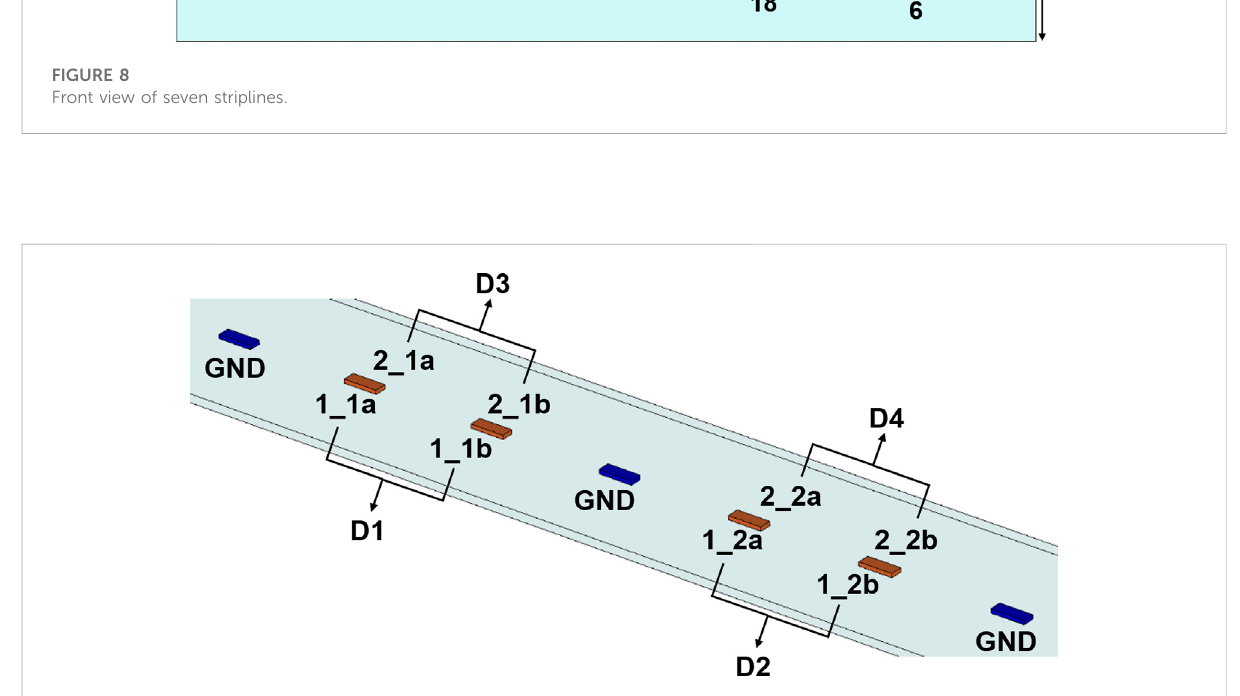
FIGURE 9 Schematic diagram of terminals and differential